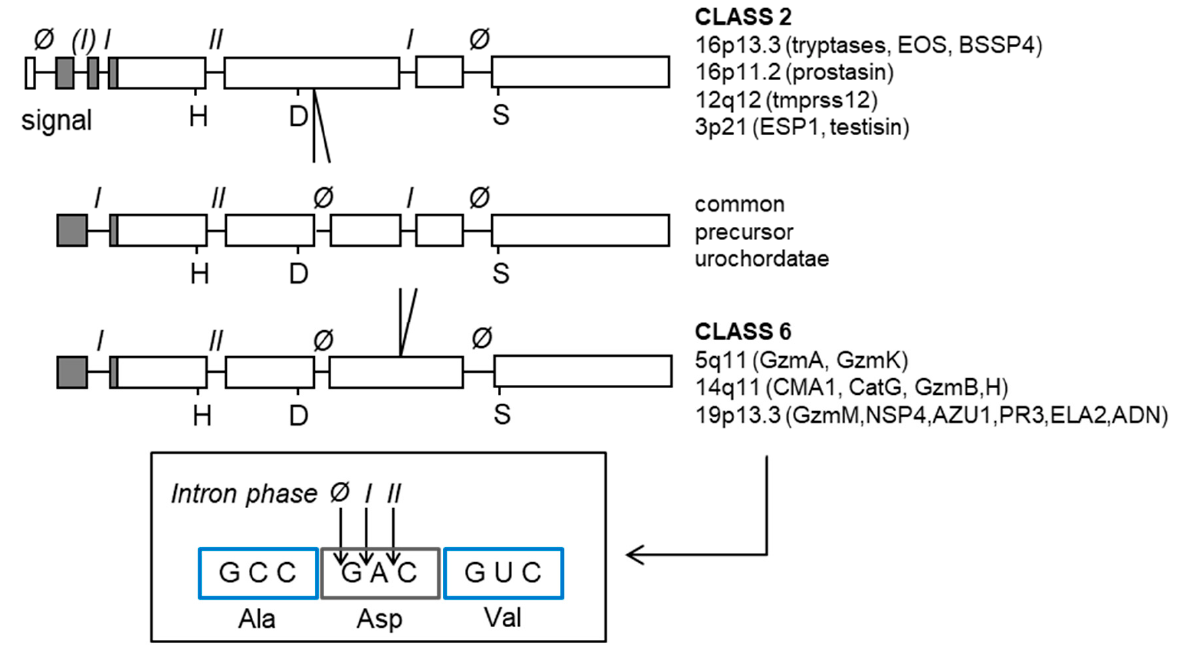
Figure 3. Exon-intron structure of different classes of proteases. Class 2 serine proteases (upper row) lost an intron of phase Ø (zero) close to Asp102 compared to the common precursor protease of urochordatae (middle row). Class 6 serine proteases lost an intron of phase I at position 149 compared to the common precursor (bottom row).